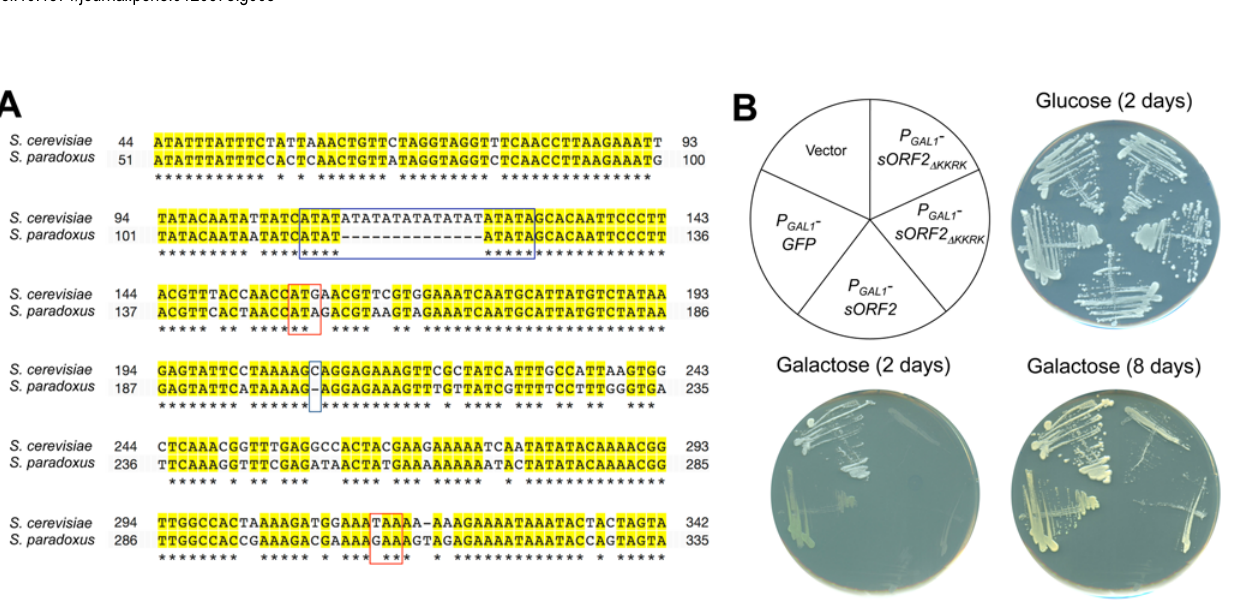
Red-squared dilutions were used to calculate the expression levels of TAP-tagged proteins. The white arrowhead indicates the expected molecular weight of Pop5-TAP protein (39.6kDa), and the black arrowhead indicates the one of sORF2-TAP (27.1 kDa). Structures of sORF2-TAP constructs are shown.